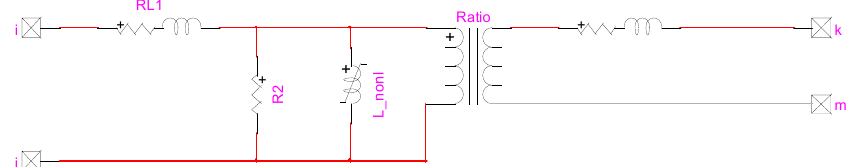
Figure 7. Basic building block for each phase of the transformer, EMTP-RV model.